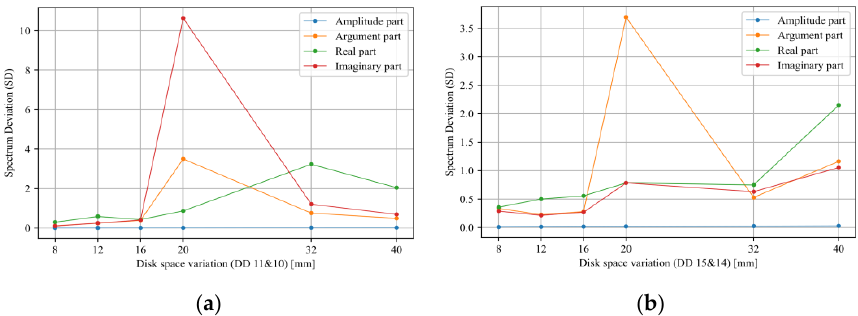
Figure 16. Feature variations based on the severity of the DSV fault in different locations for extracted by the SD index: ( a ) DSV in DD 11 and 10 ( b ) DSV in DD 15 and 14.